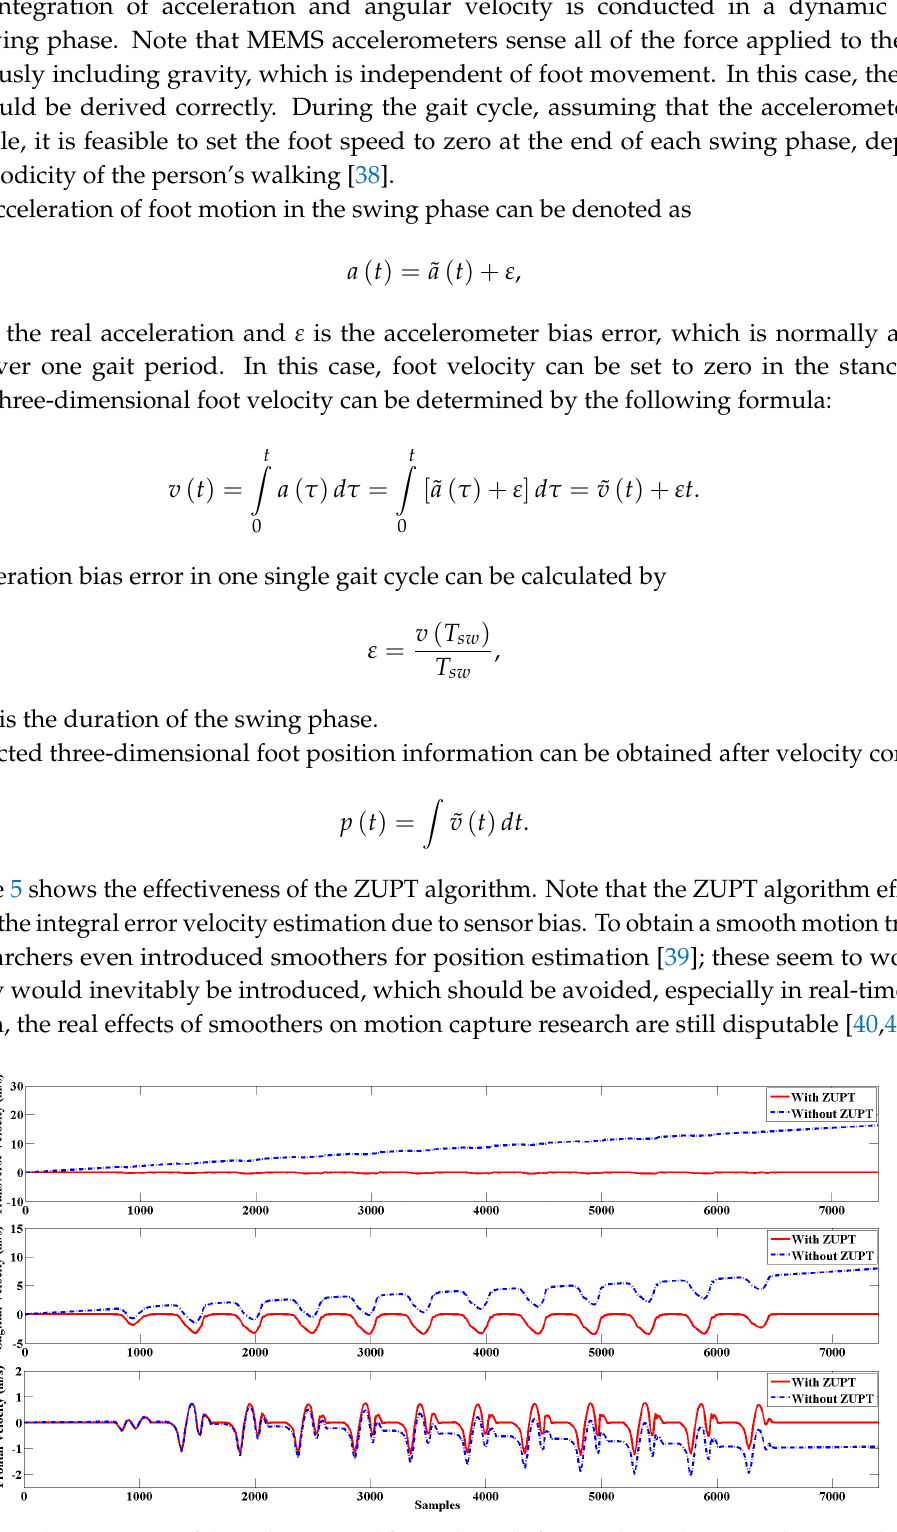
Figure 5. The estimation of three-dimensional foot velocity before applying the Zero Velocity Updating algorithm (ZUPT; blue dotted curve) and after applying the ZUPT (red